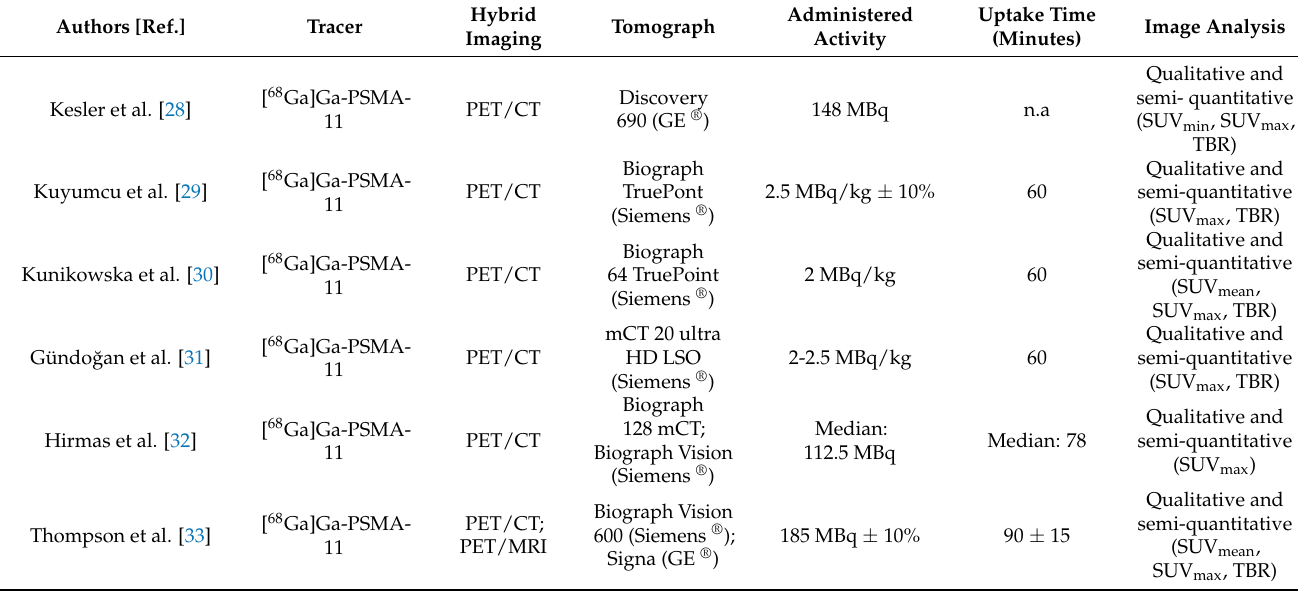
Table 3. Index test key characteristics.